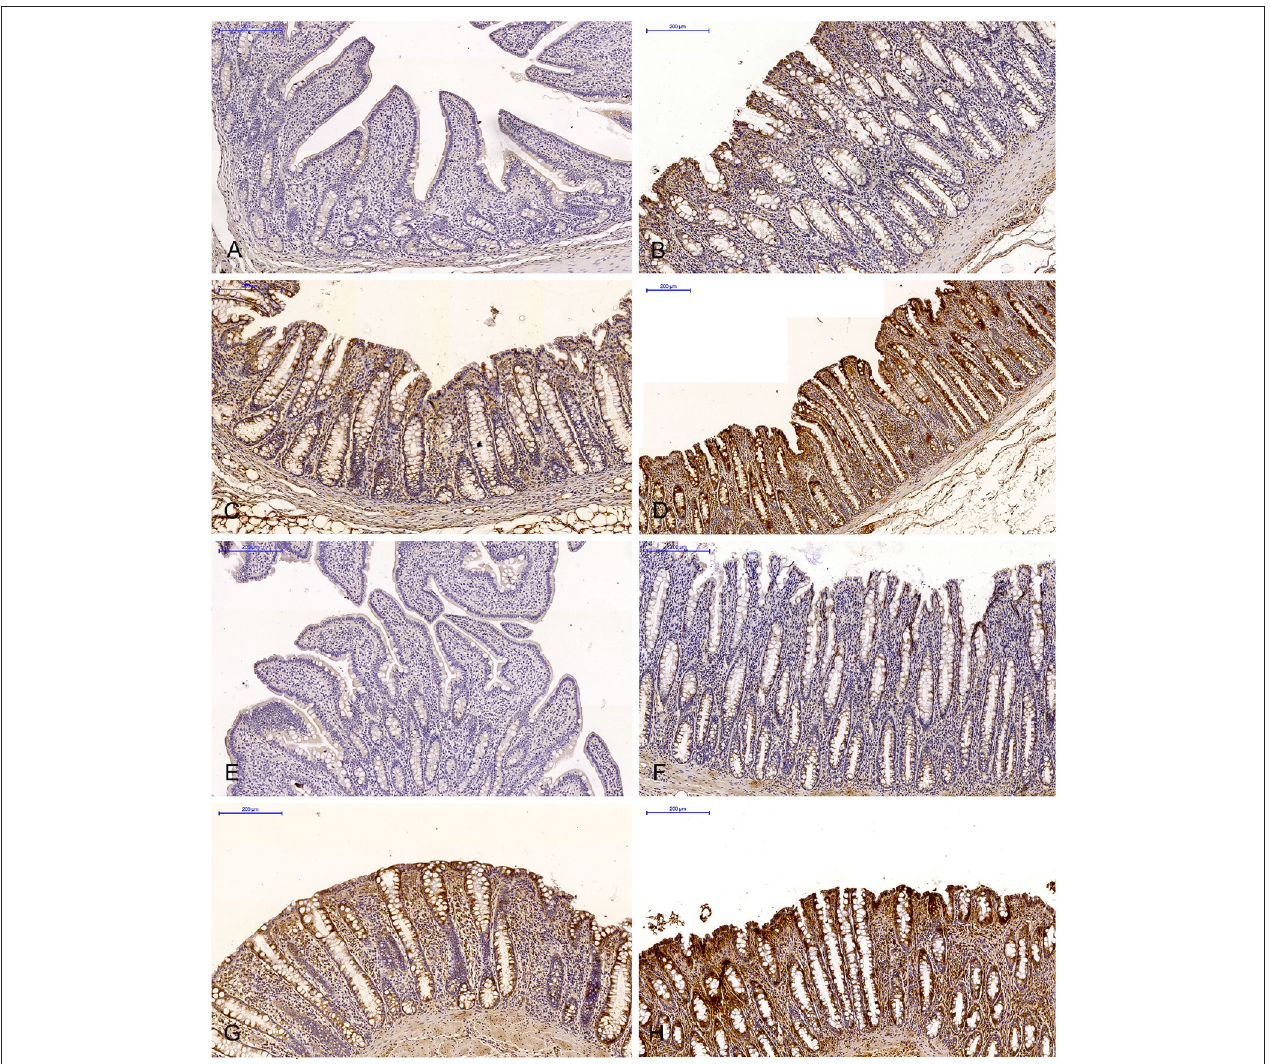
FIGURE 2 | Scanned slides of immunohistochemical expression of ER β receptors in the descending colon in group C [ (A) 0; (B) + ; (C) ++ ; (D) + + + ] and group E [ (E) 0; (F) + ; (G) ++ ; (H) + + + ].